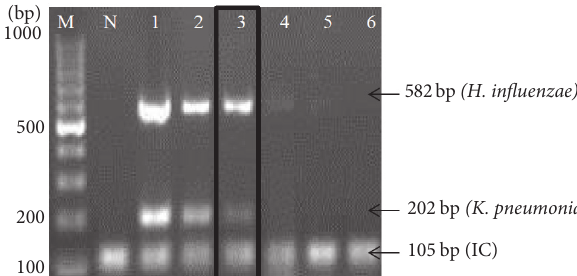
Figure 6: Analytical sensitivity of thermostabilized multiplex PCR at bacterial level for H. influenzae and K. pneumoniae. Lane: M, 100 bp DNA ladder (Fermentas, USA); N, negative control (IC); 1, positivecontrol(IC+ K.pneumoniae + H.influenzae );2,10 5 CFU/ml lysate of H. influenzae and K. pneumoniae ; 3, 10 4 CFU/ml lysate of H. influenzae and K. pneumoniae ; 4, 10 3 CFU/ml lysate of H. influenzae and K. pneumoniae; 5, 10 2 CFU/ml lysate of H. influenzae and K. pneumoniae; 6, 10 1 CFU/ml lysate of H. influenzae and K. pneumoniae